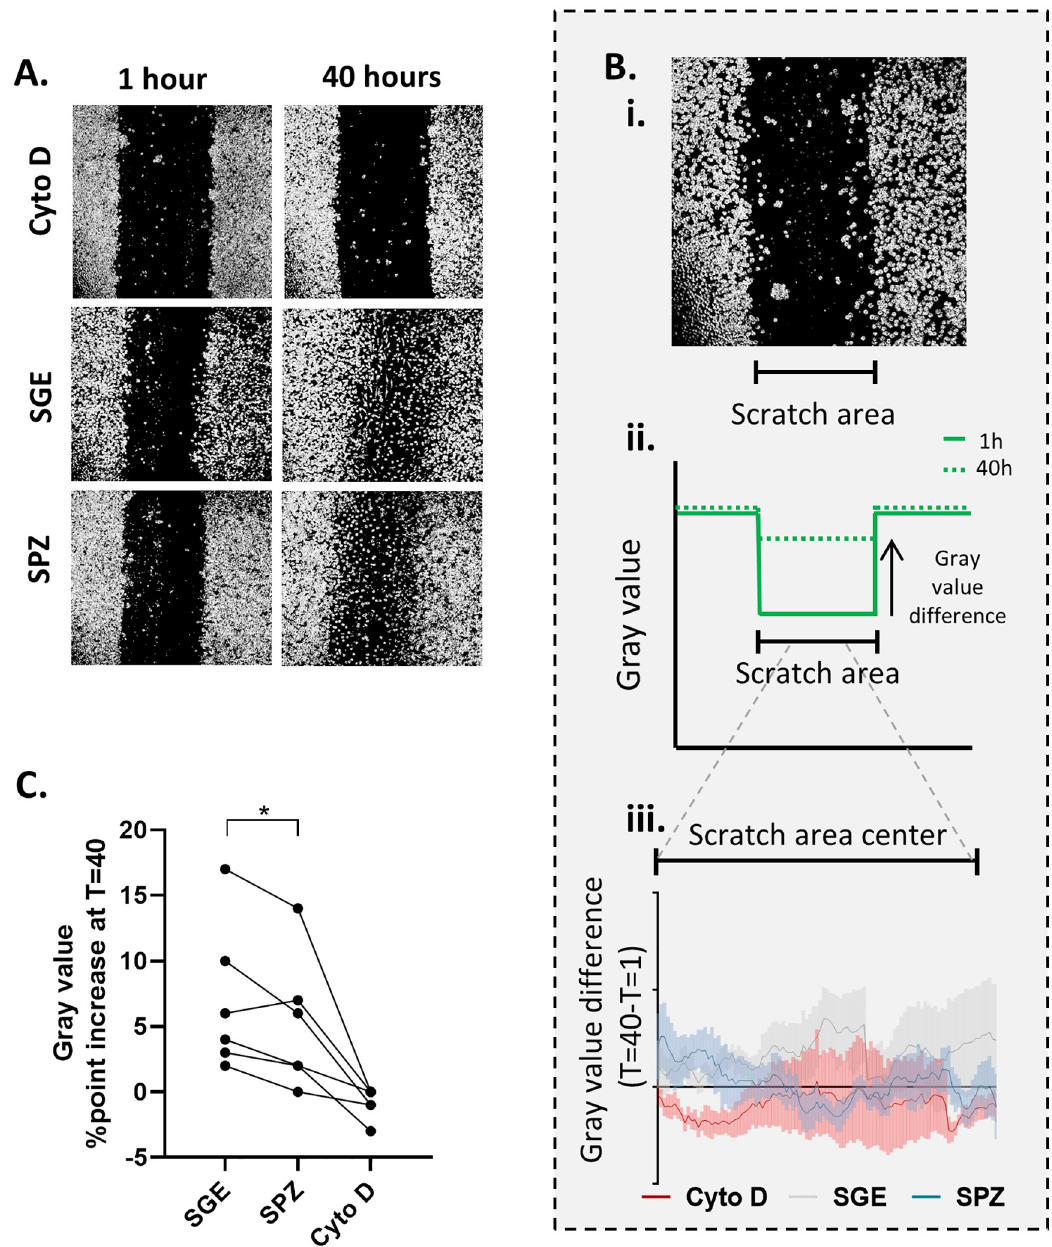
Fig 5. MoM ϕ migration upon Pf SPZ stimulation. A . Representative examples of wound closing assay. The images show wells containing MoM ϕ s (grey) with a central “wound” (black), where MoM ϕ s have been scratched away. After 40 hours, blurring of the scratch indicates migrated MoM ϕ s. Cytochalasin D (Cyto D) blocks all cell migration as control. B. i . example of a scratch with indication of scratch area to be analyzed. ii . Schematic of a surface plot of entire microscopic image. An increase in the gray value is seen over the scratch area over time, as cells fill up the wound. iii . Difference in gray value between T = 40 and T = 1 over the scratch area center, where an increased difference reflects higher migration. Lines indicate the mean of three independent experiments including six donors. Line width indicates Standard Error of the Mean (SEM). As cells migrate from the outside inward, a decrease in migration is seen primarily in the center of the scratch area. Pf SPZ stimulated MoM ϕ s display reduced wound closure after 40 hours. Statistical analysis using two way ANOVA with Tukey test for multiple comparison, SPZ compared to SGE p = < 0.0001. C . Mean percent point difference in gray value over the scratch area (T = 40-T = 1) over time per donor. Analysis using paired student’s T test � : p = <